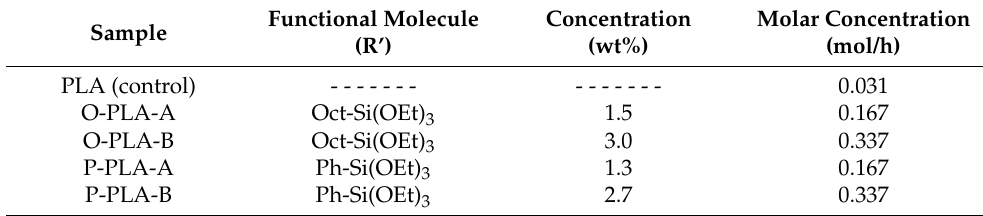
Table 1. Functionalized PLA samples through reactive